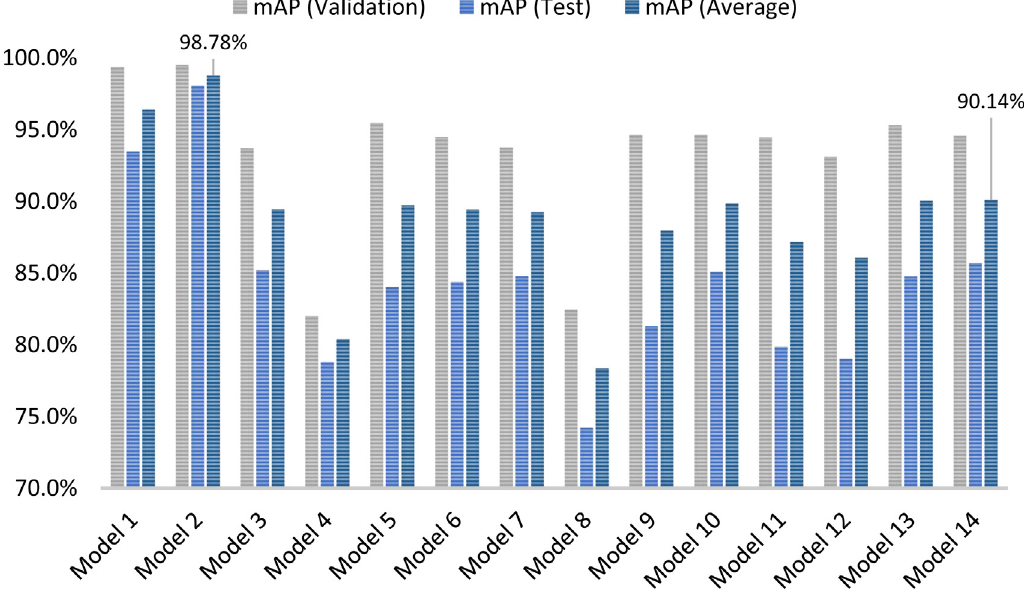
Fig. 7. The mAP values calculated from each model when performing multi-class detection (microcrack and dark region).